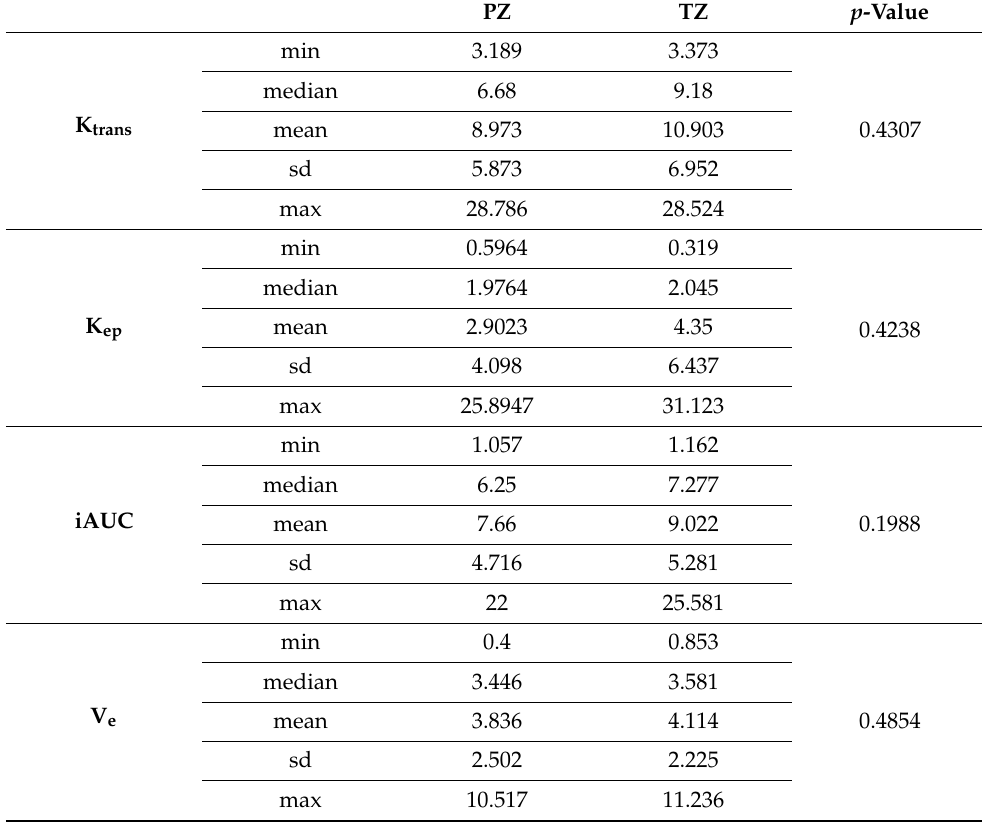
Table 3. Quantitative pharmacokinetic parameter ratio values in the peripheral (PZ) and transitional carcinoma zone (TZ) (min-minimal value; sd-standard